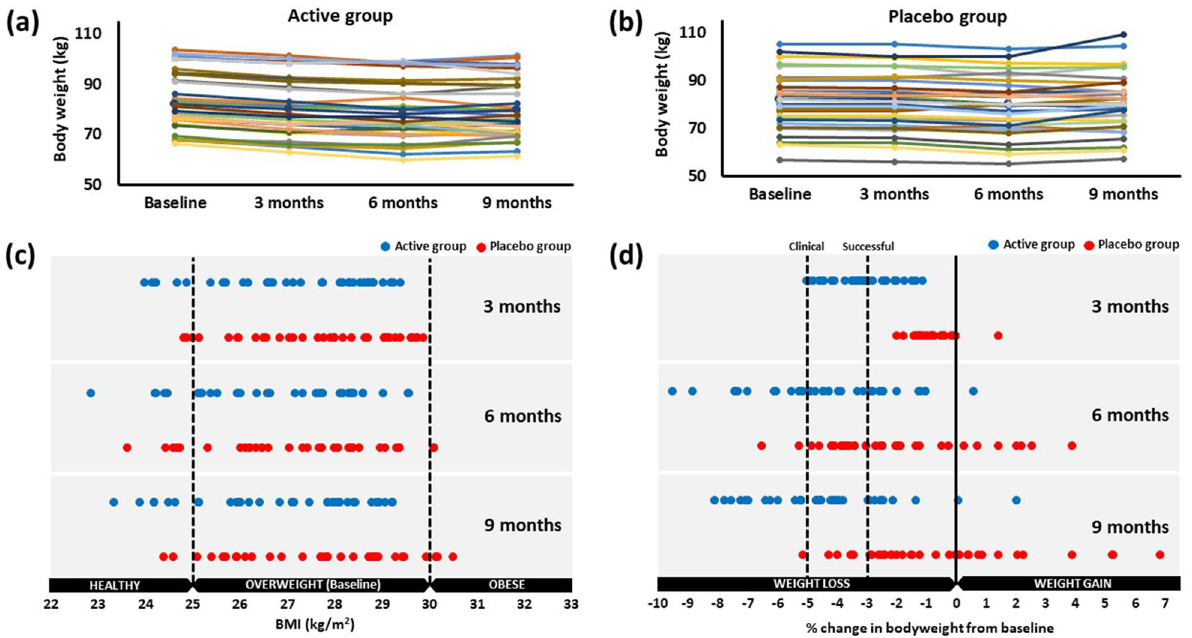
Figure 3. Absolute changes in body weight for each participant in the ( a ) active group or ( b ) placebo group over the duration of the study and the distribution of changes in participant ( c ) BMI and ( d ) percentage change in body weight. Data is presented for 35 participants per group.